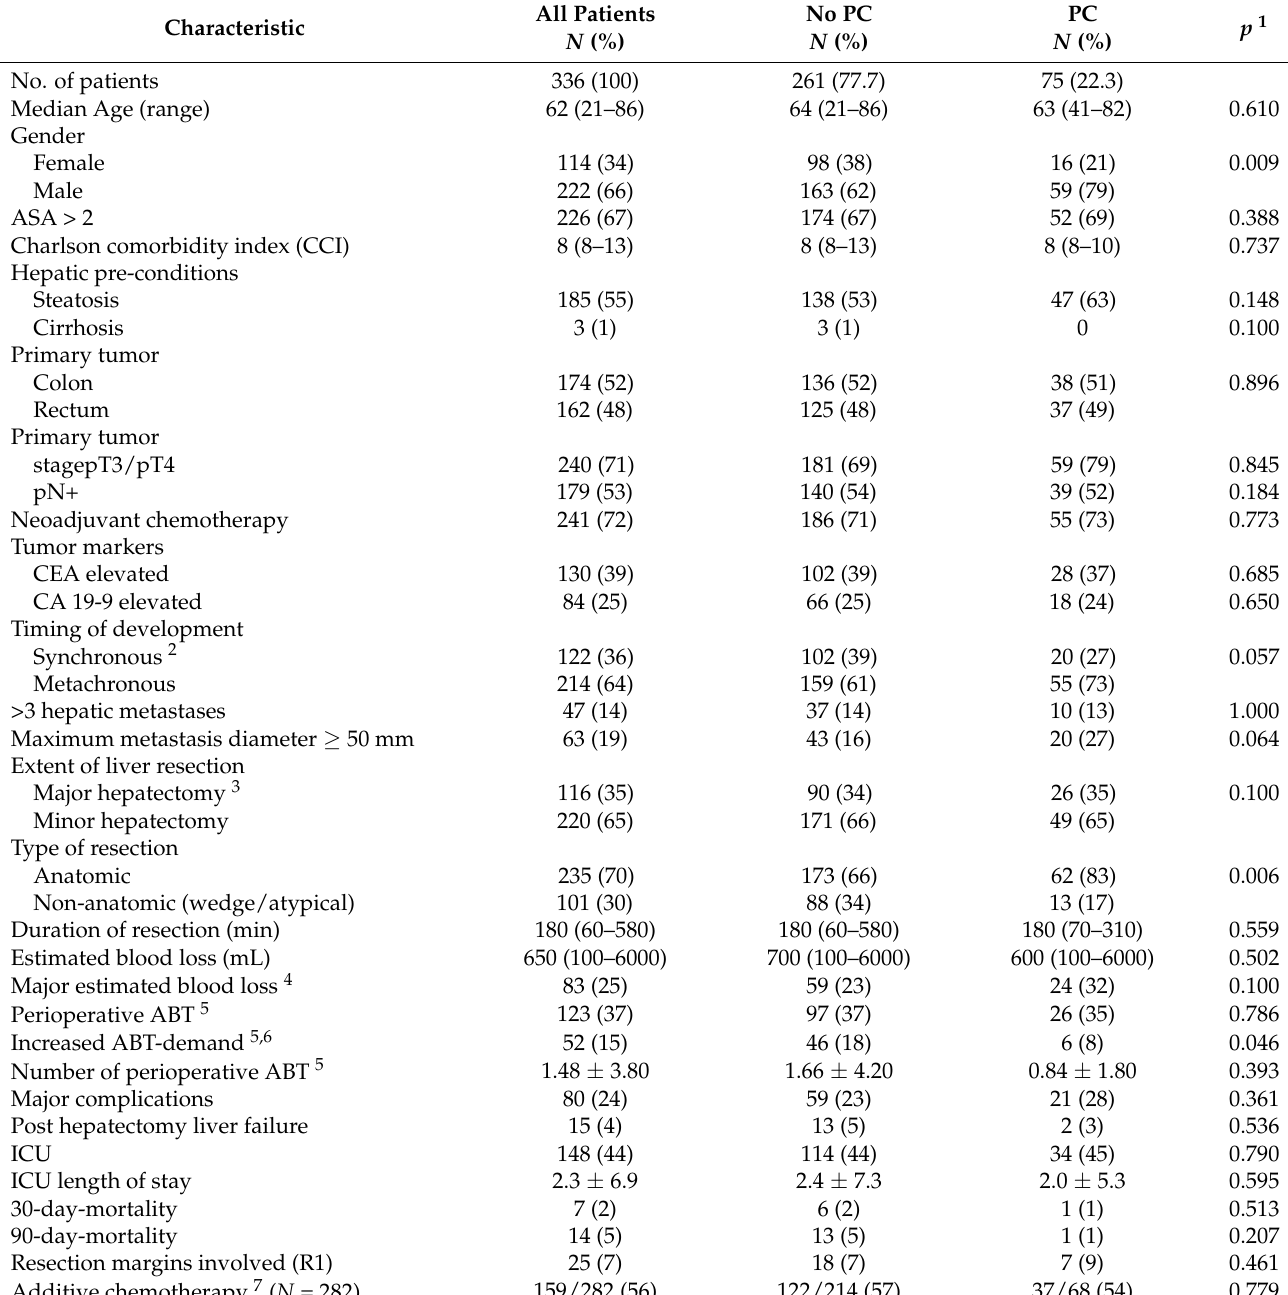
Table 1. Clinical characteristics of patients with and without pedicle clamping